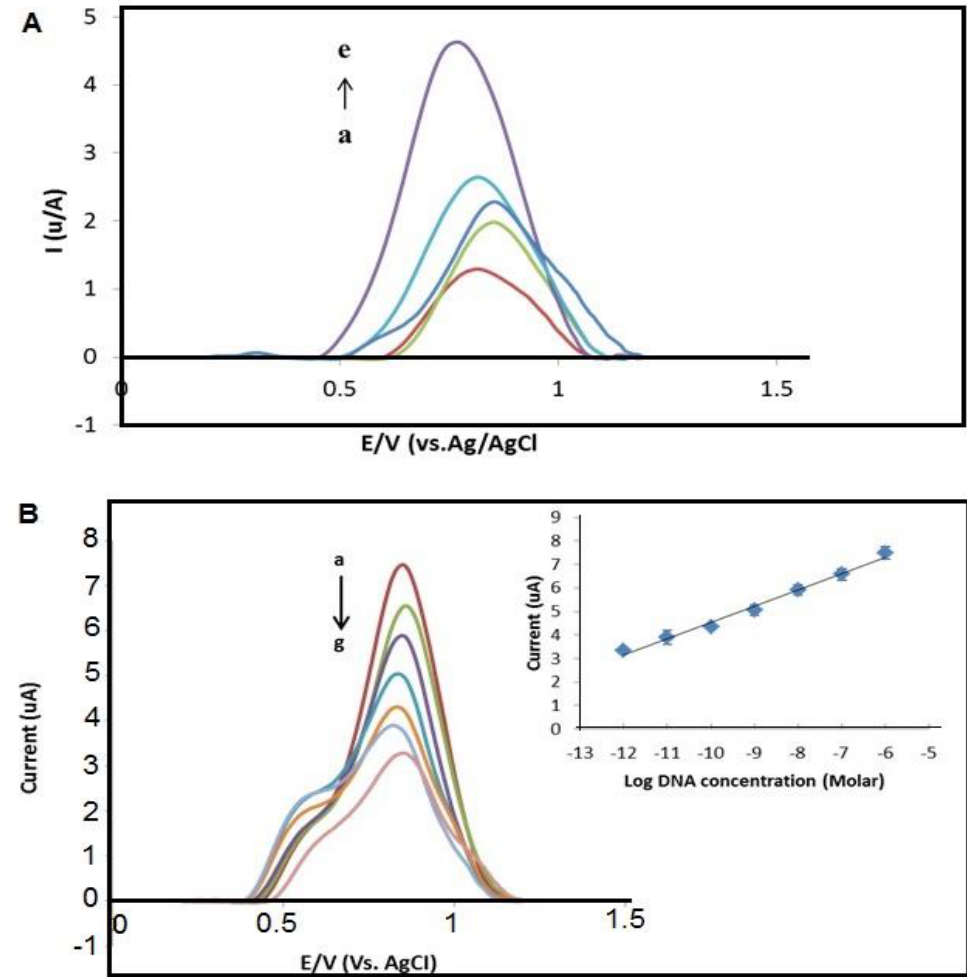
Figure 4. Differential pulse voltammetry (DPV) curve for oxidation of Ru(bpy) 32 + : ( A ) (a) SPCE / MPA-Fe 3 O 4 / NCC / CTAB / EDC / NHS, (b) SPCE / MPA-Fe 3 O 4 / NCC / CTAB / EDC / NHS / DNA probe, (c) SPCE / Fe 3 O 4 / NCC / CTAB / EDC / NHS / mutation-DNA, (d) SPCE / MPA-Fe 3 O 4 / NCC / CTAB / EDC / NHS / non-complementary-DNA, (e) SPCE / MPA-Fe 3 O 4 / NCC / CTAB / EDC / NHS / DNA-DNA target, in TE buffer (pH 8) containing 25 µM Ru(bpy) 32+ ; ( B ) DPV curve at different concentration of complementary target DNA. Inset is a linear relationship between the DPV peak current (Ip) and the different concentrations of complementary DNA (from a to g were 1.0 × 10 −6 M to 1.0 × 10 −12 M) in TE buffer pH 7. Table 1. Comparison between the present work and other reported techniques for the detection of tuberculosis (TB) developed on screen-printed electrode.